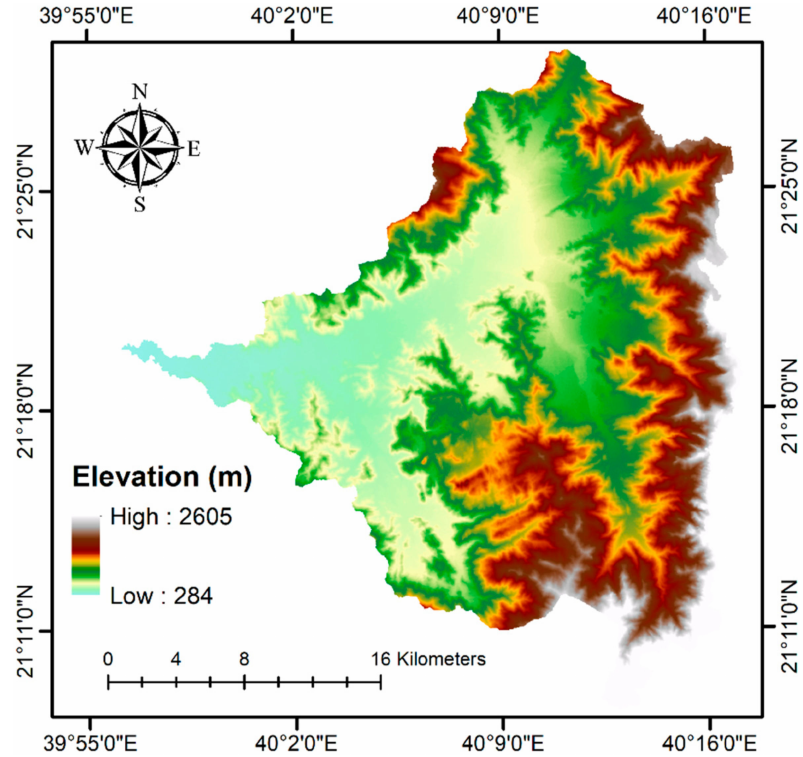
Figure 3. The digital elevation map of the study area.